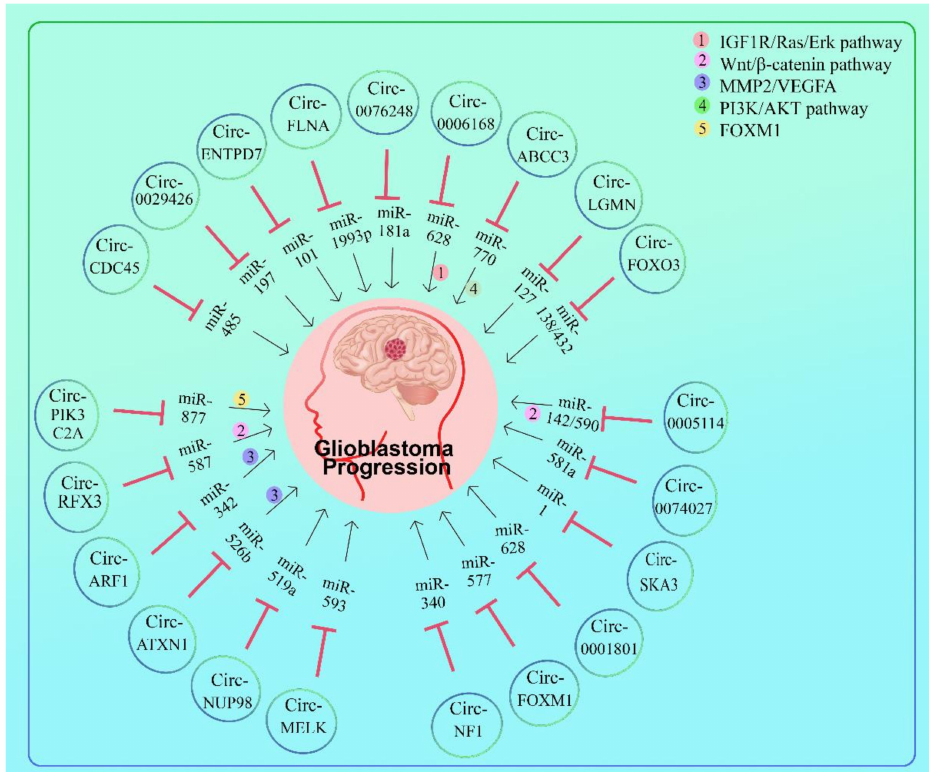
Figure 4. CircRNAs responsible for upregulation of glioblastoma growth: A schematic representation of the circRNAs involved in the regulation of glioma cell proliferation, migration, and invasion, among other functions. Numerous known circRNAs operate as miRNA sponges, subsequently increasing the amount of expression of the appropriate target gene. These target genes or proteins further influence downstream factors involved in cancer signaling pathways by functioning as transcription factors or regulatory proteins, as well as through other mechanisms. CircRNAs such as circ-CDC45, circ-0029426, circ-ENTPD7, circ-FLNA, hsa-circ-0076248, circ-0006168, circ-ABCC3, circ-LGMN, circ-FOXO3, hsa-circ-0005114, circ-0074027, circ-SKA3, circ-0001801, Circ-FOXM1, circ- NF1, circ-MELK, circ-NUP98, circ-ATXN1, circ-ARF1, circ-RFX3, and circ-PIK3C2A are responsible for the up-regulation of glioblastoma growth through different pathways including those of the IGF1R/Ras/Erk, Wnt/ β -catenin, MMP2/VEGFA, PI3K/AKT, and FOXM1. For example, circ-RFX3 activates the Wnt/ β -catenin pathway through